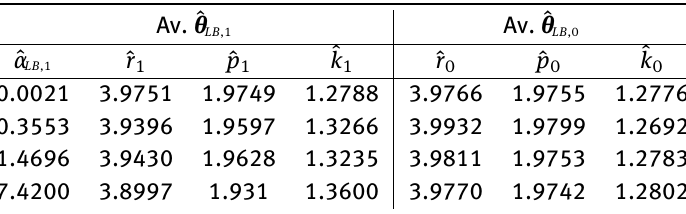
Table 3: A.v MLE’s for θ LB , using parametric copula method, under hypotheses H 1 and H 0 for N = 5000, n = m = 1000, r = 4 and p = 2 .